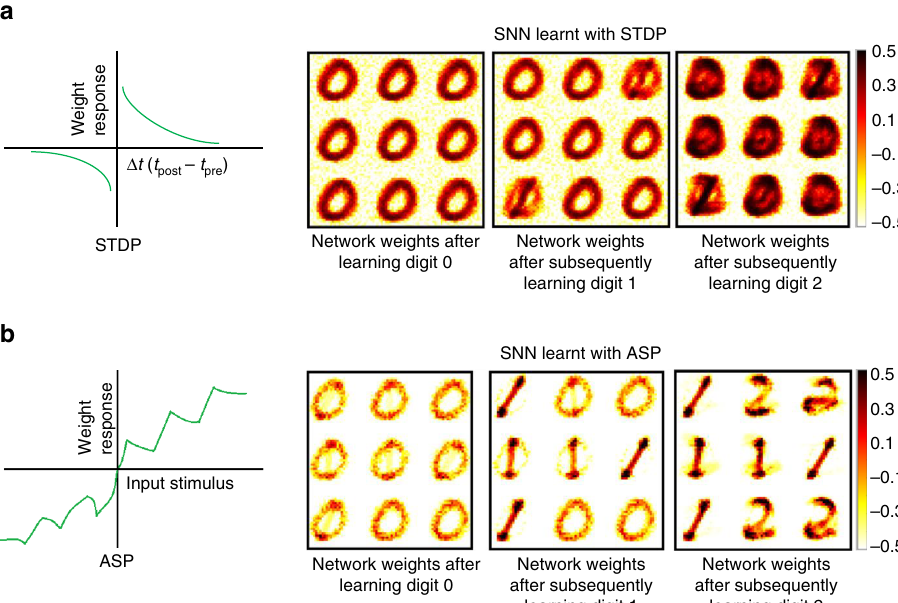
Fig. 3 Learning by forgetting. a , b Digit representations learnt with digits 0 through 2 shown sequentially to an Spiking Neural Network ( SNN ) (with nine excitatory neurons) trained with standard spike-timing dependent plasticity ( STDP ) ( a ) and adaptive synaptic plasticity ( ASP ) that integrates habituation ( b ). Presenting the digits one-by-one sequentially i.e., fi rst all the images for digit 0 followed digit 1, and so on can be treated as a dynamic learning environment. No particular digit instance or class is re-shown to the network. SNN trained with STDP tried to learn the new digit representation (for instance, digit 1) while retaining a portion of the old data (for instance, digit 0). However, fi xed network size and absence of data reinforcement (i.e., no old data or digit showing with the new data) resulted in accumulation causing new weight updates to coalesce with already learnt patterns rendering the network incapable of categorizing the digits. In sharp contrast, ASP-learnt SNN, with identical resource constraints in place, gracefully forgets old patterns and adapts to learn new inputs effectively without catastrophically erasing old data. Supplementary Fig. 10 shows the representations learnt for a larger network when all digits 0 through 9 are presented. The color intensity of the patterns are representative of the value of synaptic weights with lowest intensity ( white ) corresponding to a weight value of − 0.5 and highest intensity ( black ) corresponding to